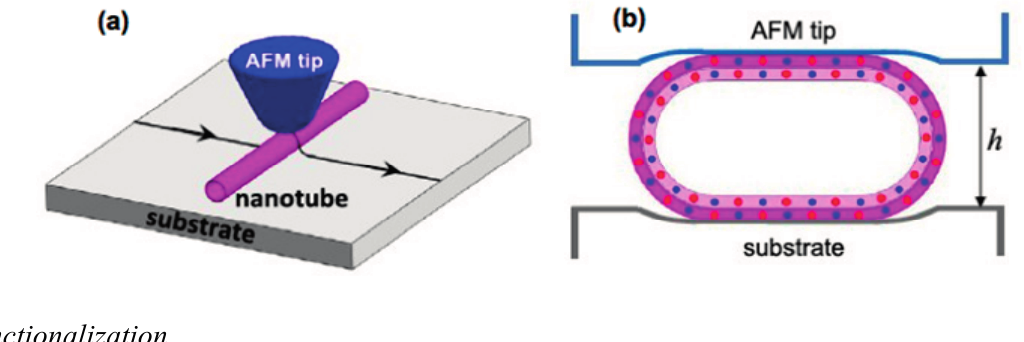
Figure 3. ( a ) Schematic of the AFM-based compression scheme for the radial deformation of individual BNNT on a flat substrate. ( b ) Schematic diagram of a radially deformed BNNT between an AFM tip and a substrate. Reprinted with permission from [87]; © 2012 IOP PUBLISHING.